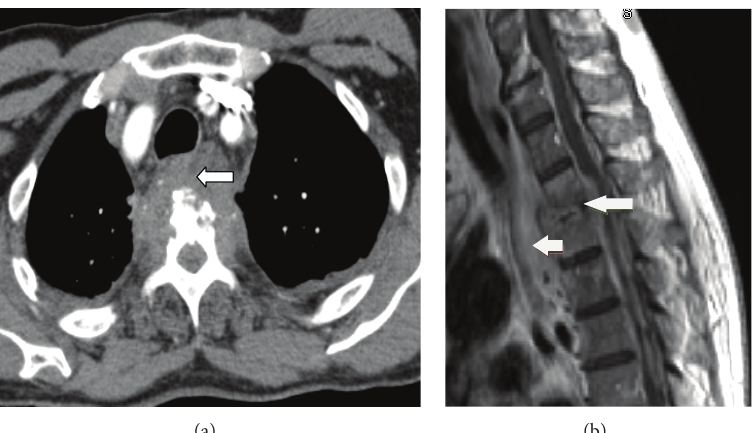
Figure 1: (a) CT angiogram chest showing a large soft tissue mass at the T3-T4 vertebral space with associated osseous destruction of the T4 vertebral body. (b) MRI of the thoracic spine, T1 weighted, showing T3-T4 disk space narrowing, endplate destruction, and marrow edema. There is also a soft tissue mass extending from the space anteriorly in the prevertebral